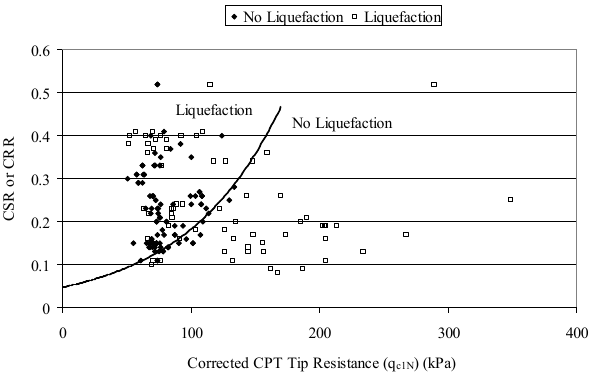
Fig. 4. Performance of Robertson and Wride’s (1998) formulation for training dataset.